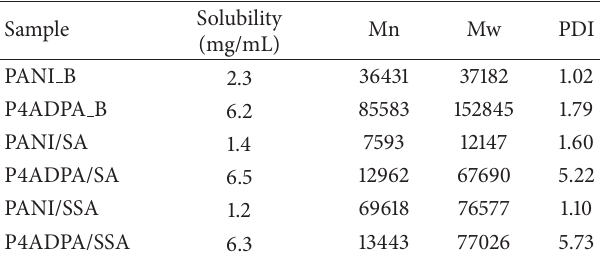
Table 1: Materials solubility in DMF and Mw (weight average molecular weight), Mn (number average molecular weight), and PDI (polydispersity index, Mw/Mn) of soluble fractions as deter- mined by SEC